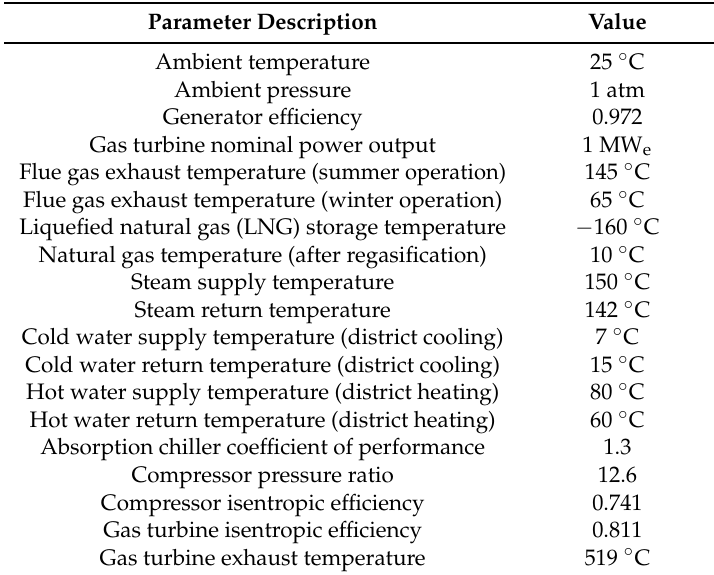
Table 1. Values of the system input